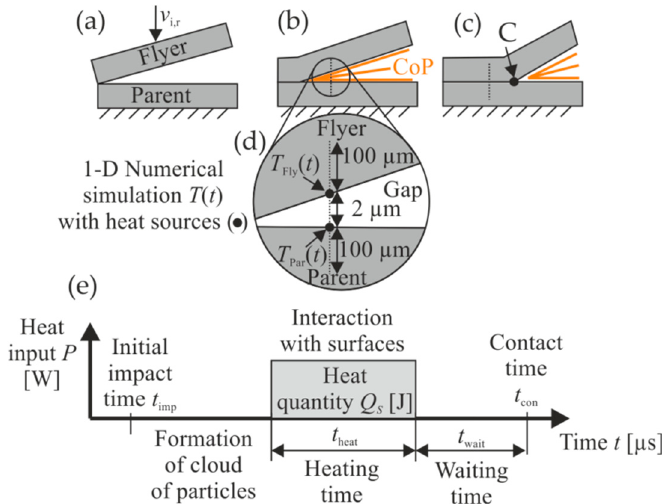
Figure 4. Process steps during MPW showing: ( a ) the initial collision, ( b ) the cloud of particles (CoP) formation and surface activation and ( c ) the surface contact with the moving contact point C, ( d ) dimensions of the 1-D model, ( e ) modeling scheme with the temporal course of the heat input and contact time. Table 4. Material specific values (temperature independent during the simulations).